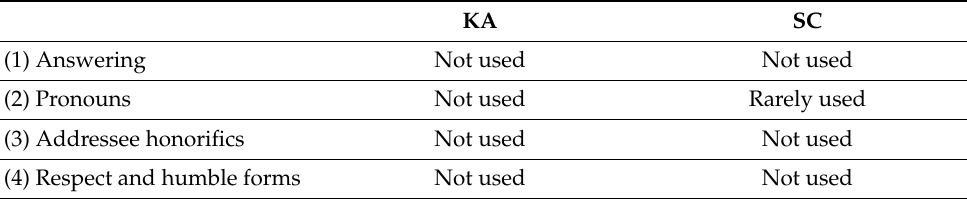
Table 4. Traditional honorifics choices of wives towards their